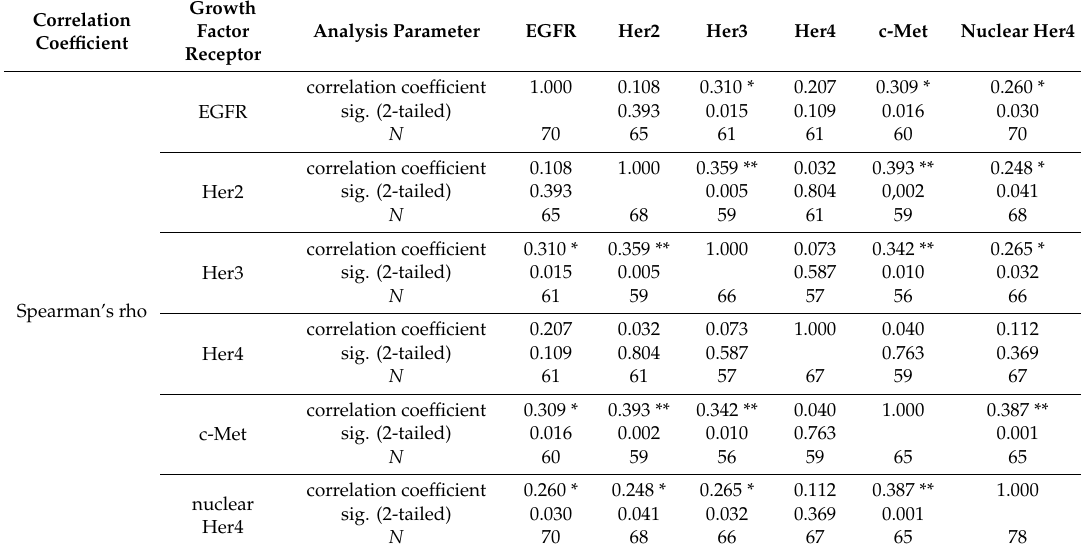
Figure 3. ( a ) Heatmap of growth factor receptor expression in primary tumors sorted by EGFR expression and expression values converted from a 0–300 to a 0–100 scale; and ( b ) heatmap of growth factor receptor expression in all assessed tumor tissues (primary tumor, local recurrent tumor, lymph node metastasis and distant metastasis) sorted by EGFR expression, expression values converted from a 0–300 to a 0–100 scale. Table 3. Bivariate correlation analysis among the growth factor receptor expression of EGFR, Her2, Her3, Her4 and c-Met.